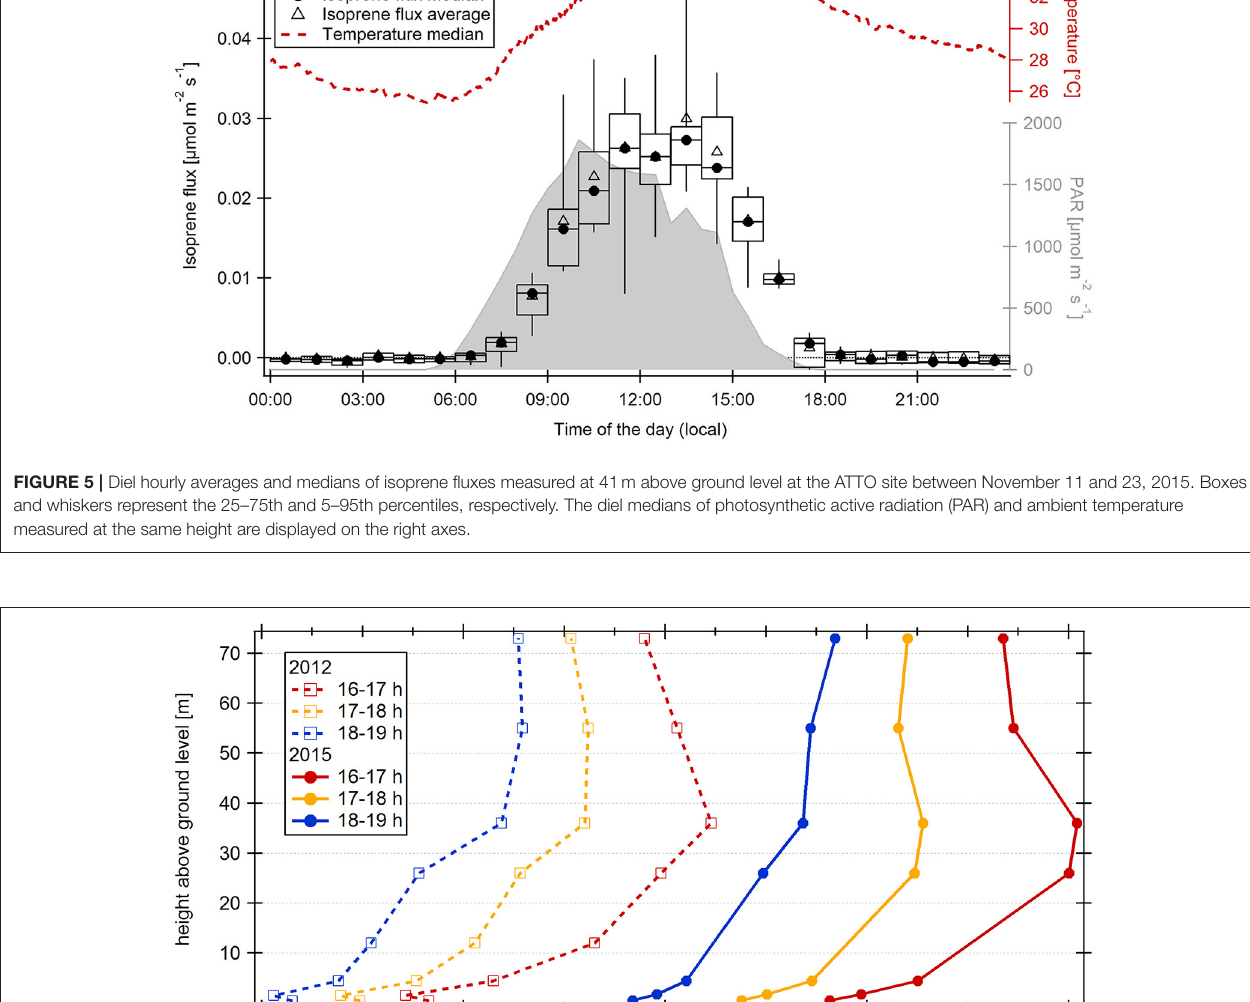
Supplementary Figure 8 in comparison with observations,